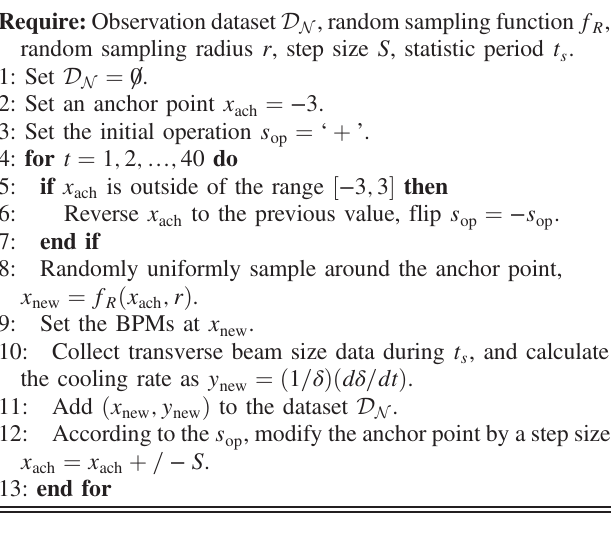
Algorithm 2. Initial Sampling Routine.